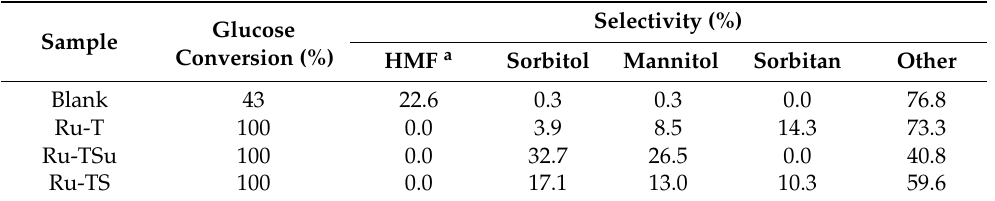
Table 7. Glucose conversion and selectivity to several